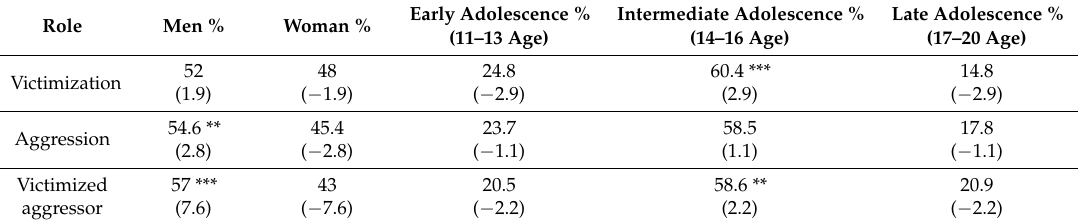
Table 4. Role descriptive (Special Educational Needs -SEN-) by gender and